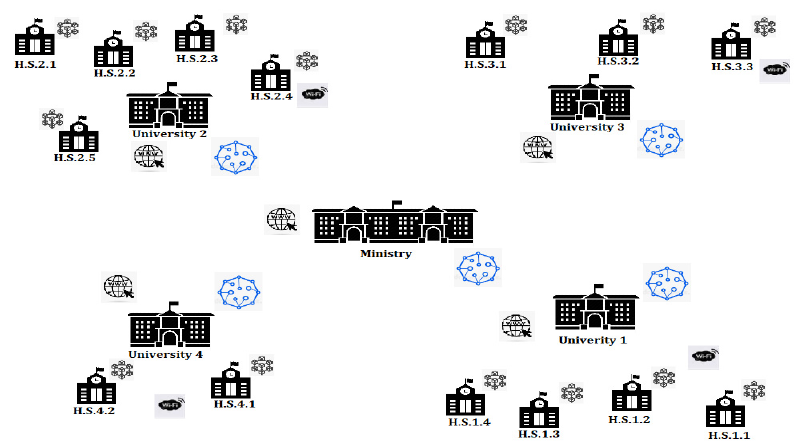
Figure 2. Proposed Figure 2. Proposed approach.